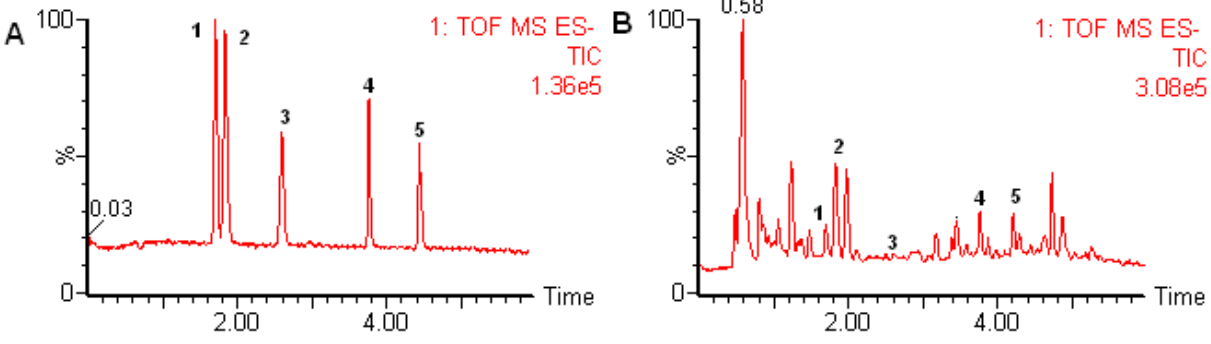
Figure 2. Total ion chromatogram in negative ion mode of standard ( A ) and sample solutions ( B ); 1 : syringing; 2 : chlorogenic acid; 3 : caffeic acid; 4 : eleutheroside E; 5 : isofraxidin.